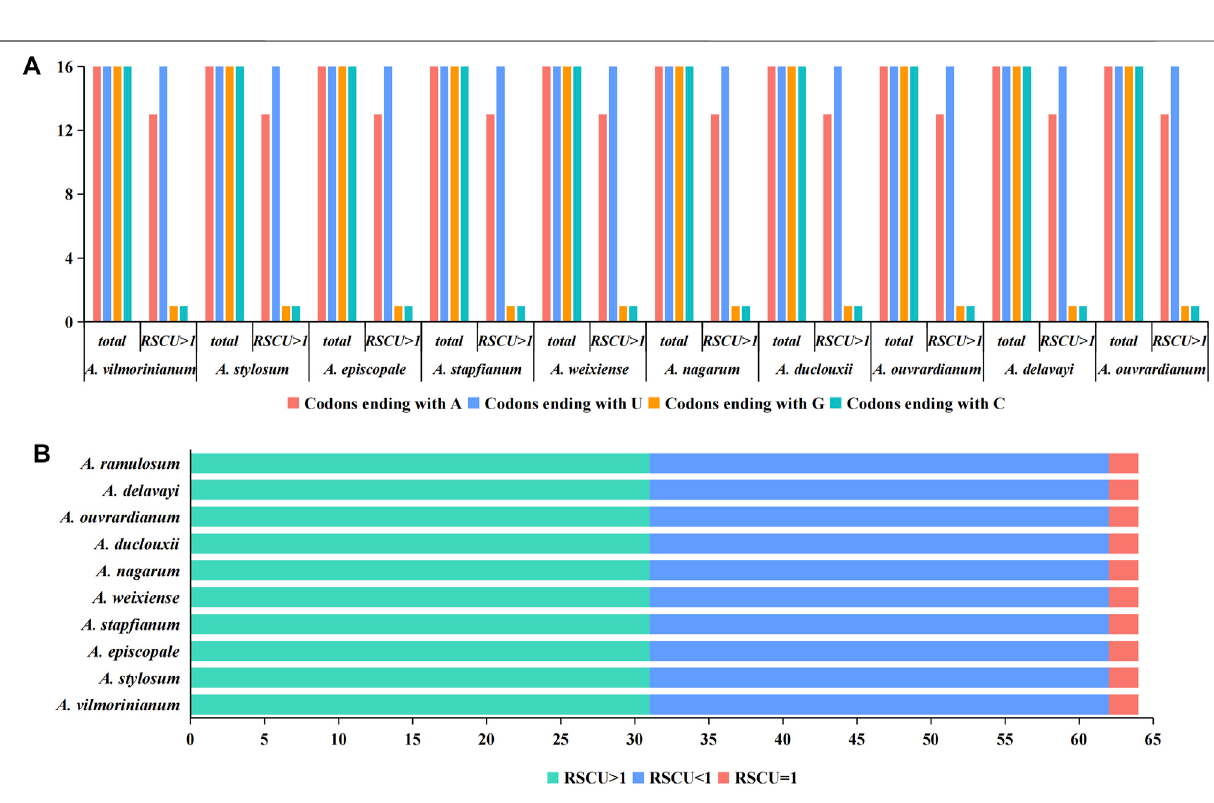
Frontiers in Genetics |